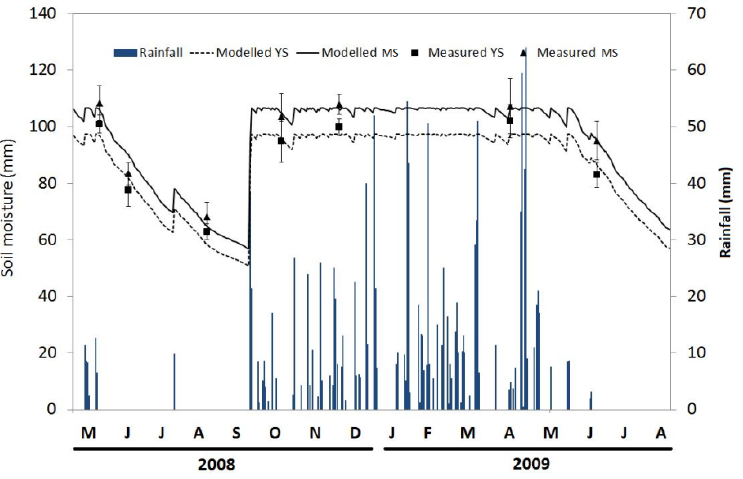
Figure 4. Seasonal variations of observed precipitations (black bars) as well as modelled (YS: dotted line, MS: solid line) and observed (YS: filled square, MS: filled triangle) soil SWC of the top soil layer (0–30 cm). Error bars are standard errors of the